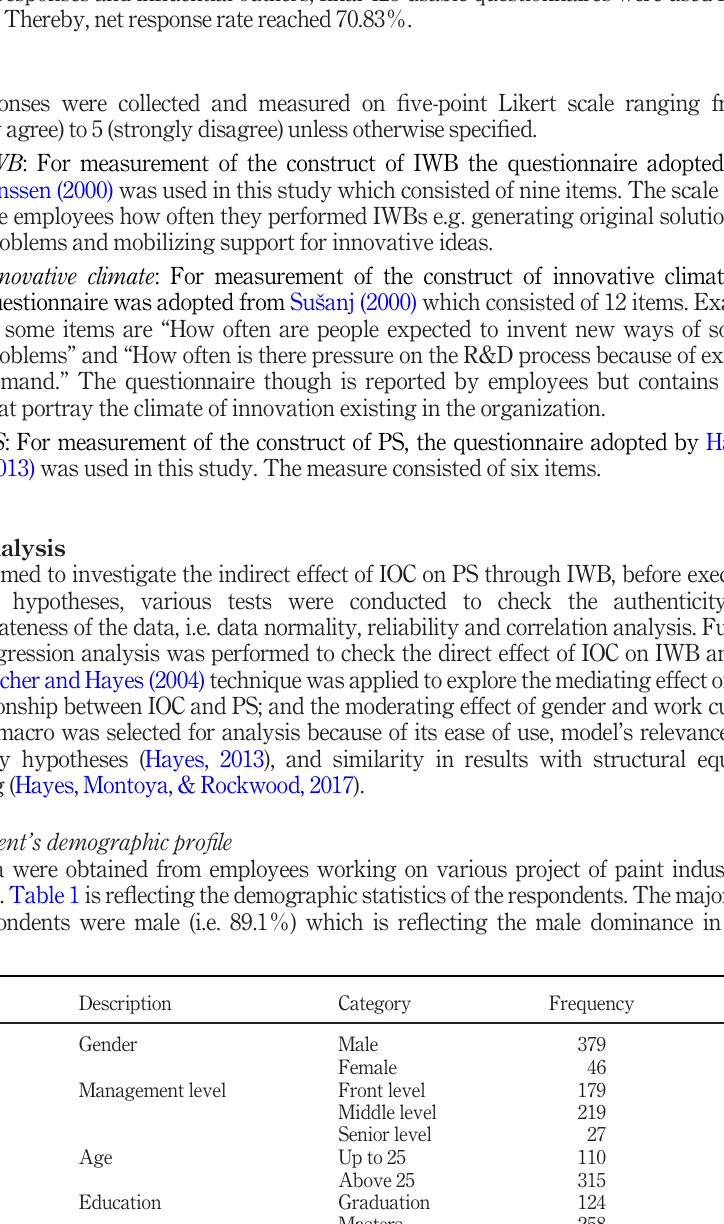
Table 1. Respondent ’ s demographic pro fi le